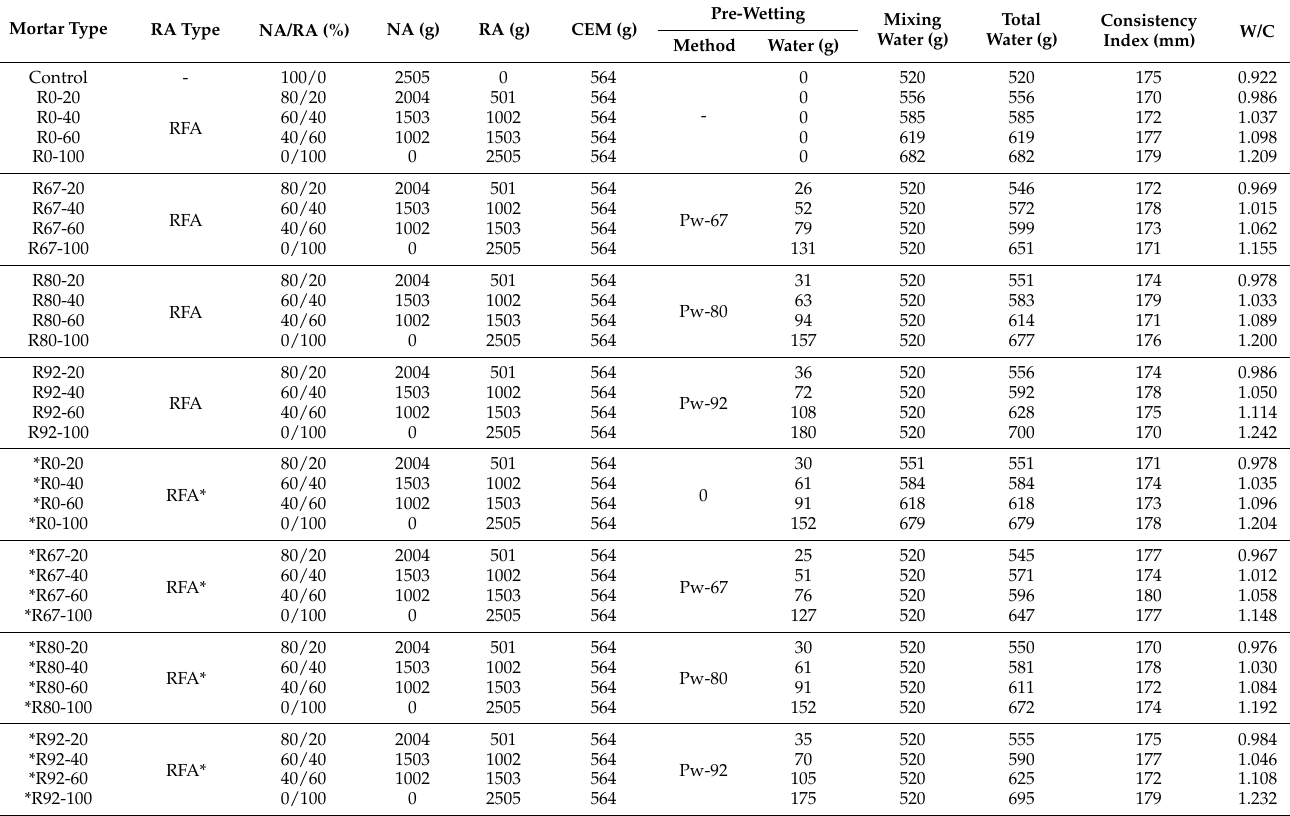
Table 4. Mortar mixture